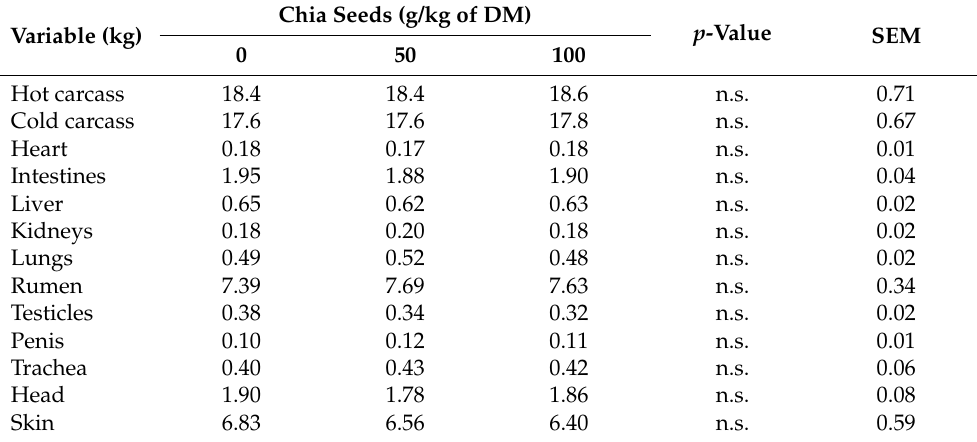
Table 3. Means of weight of non-meat components of finishing lambs fed diets with chia seeds.